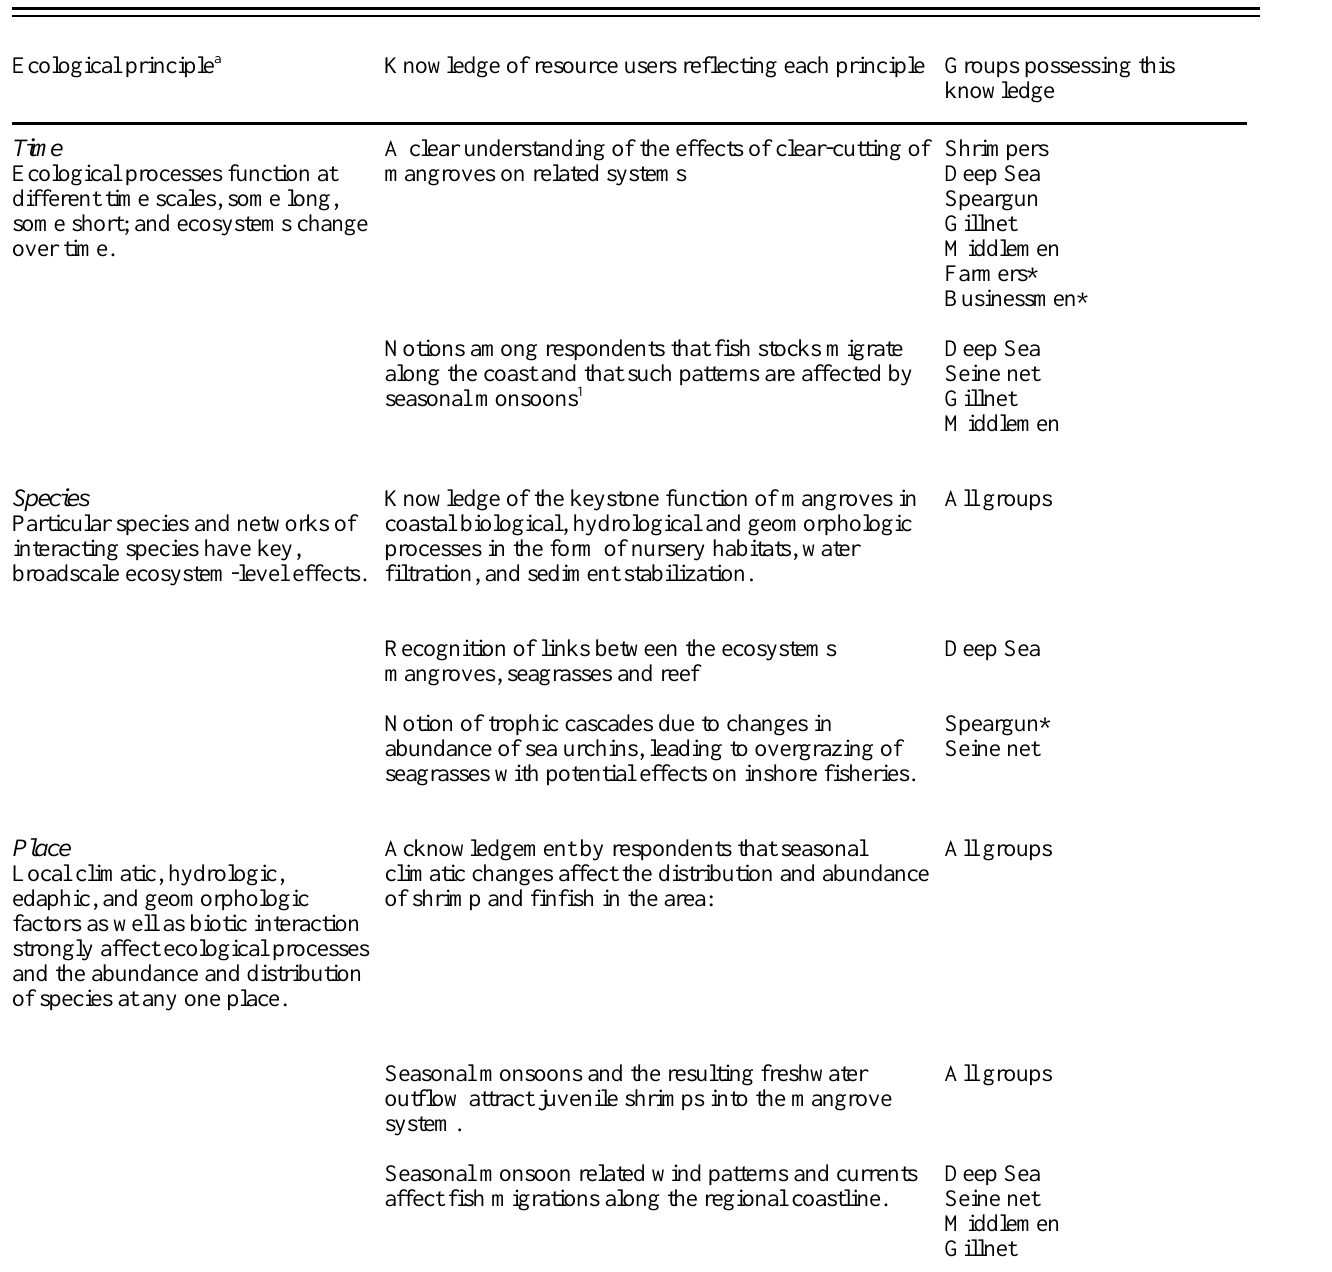
Table 2. Local ecological knowledge among groups of resource users, i.e., occupational categories, using different gear types and operating in distinct but overlapping subsystems of a coastal seascape in Kenya. The knowledge is classified and related to the ecological principles defined by Dale et al. (2000 a ). Occupational category is based on main gear type used and groups are listed in this column according to the ecological knowledge they were found to possess. * groups exhibiting much less detailed understanding of links and processes 1 Differences in scale of the fish migrations acknowledged by different groups. Deep Sea, Gillnet fishermen and Middlemen all perceive migrations on a local and regional scale, whereas Seine net fishermen spoke only of fish migrations at a local scale in the